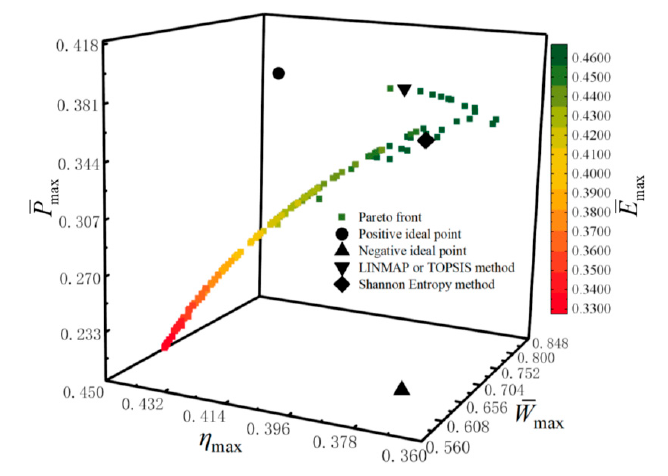
Figure 17. Pareto frontier with W , η , P and E as the optimization objectives.